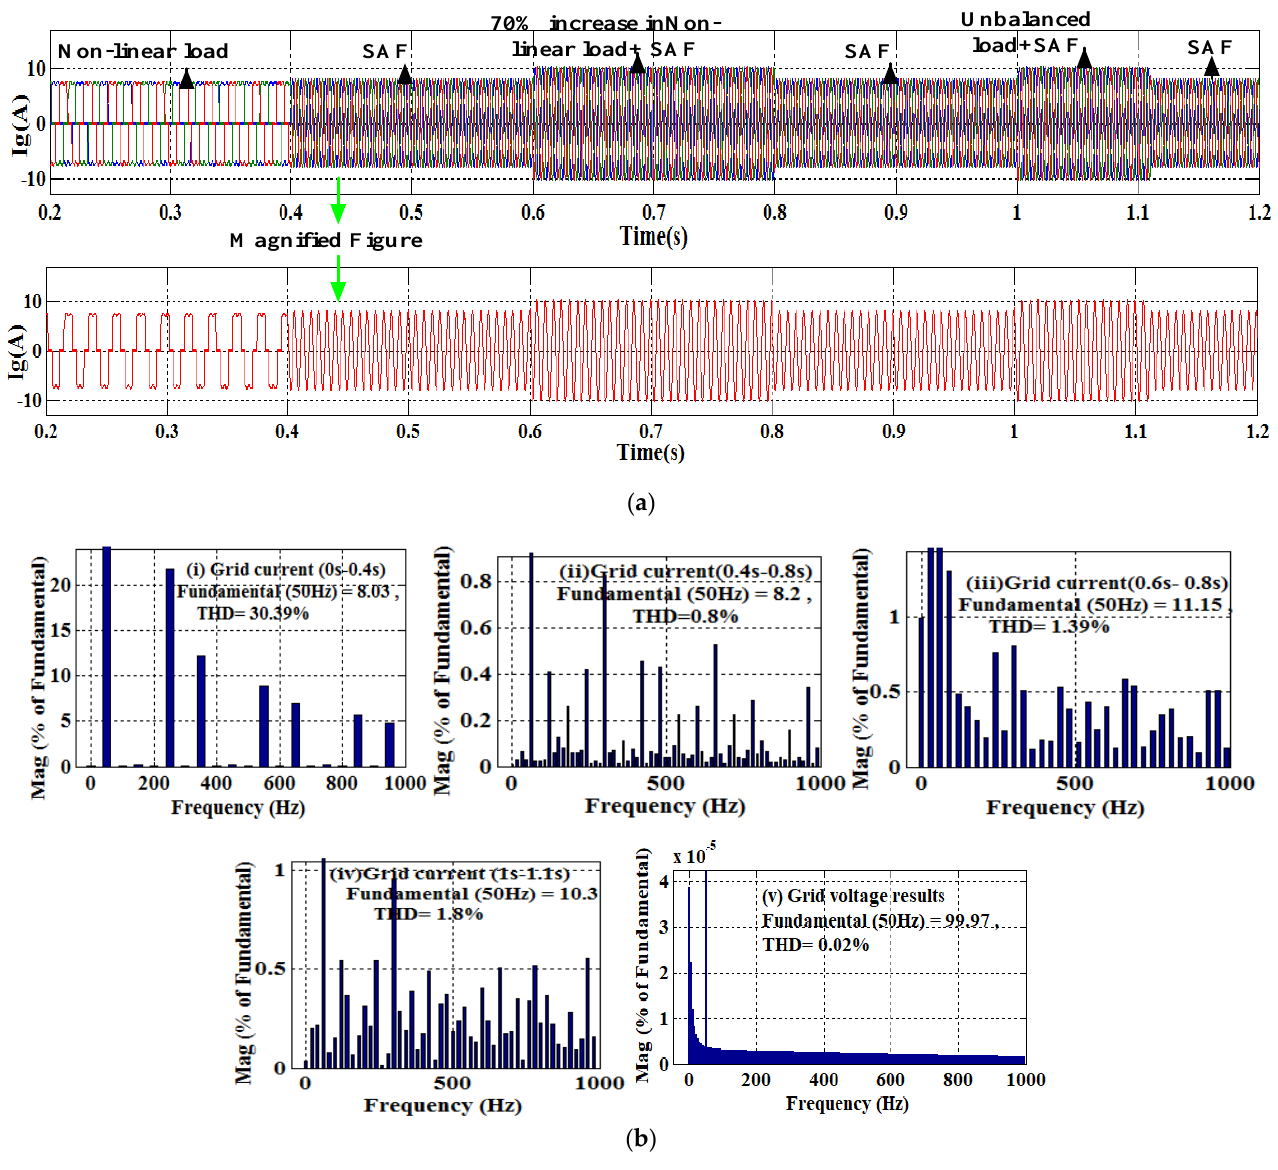
Figure 10. ( a ) Proposed grid current results ( b ) Proposed FFT results.